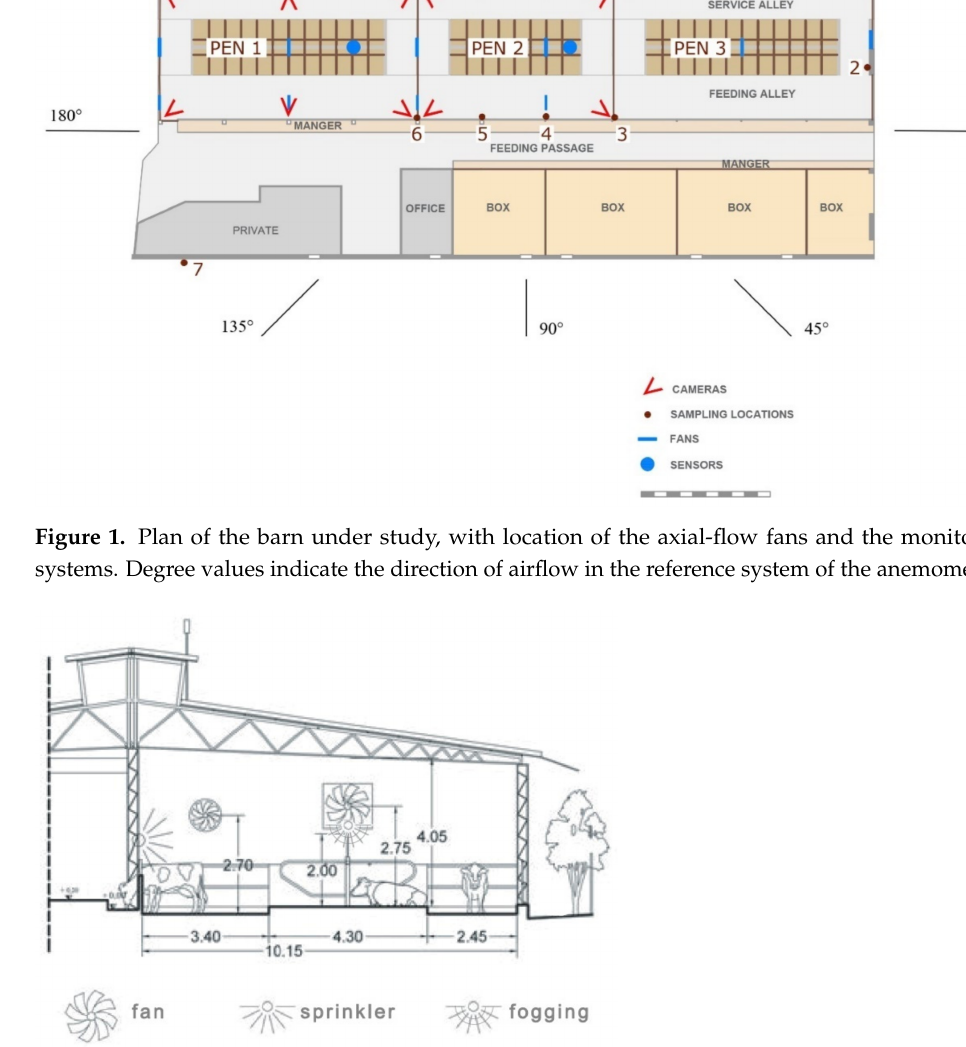
Figure 2. Section of the area under study and location of the cooling system